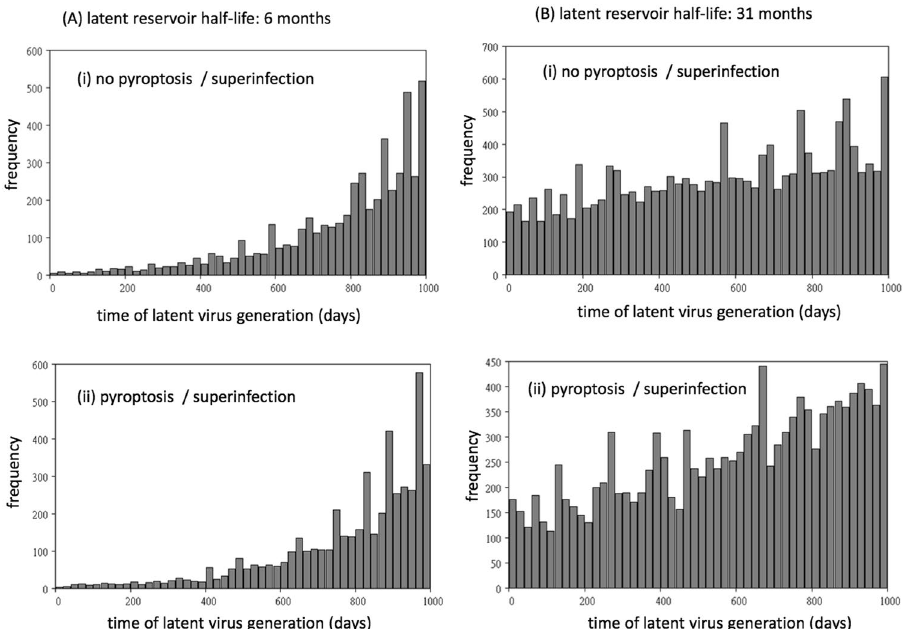
Figure 4. Influence of a stronger immune response on the archiving of viral genomes. Computer simulation was the same as in Fig. 3, except for the two parameters C = 10 and F = 10, which simulate a stronger immune